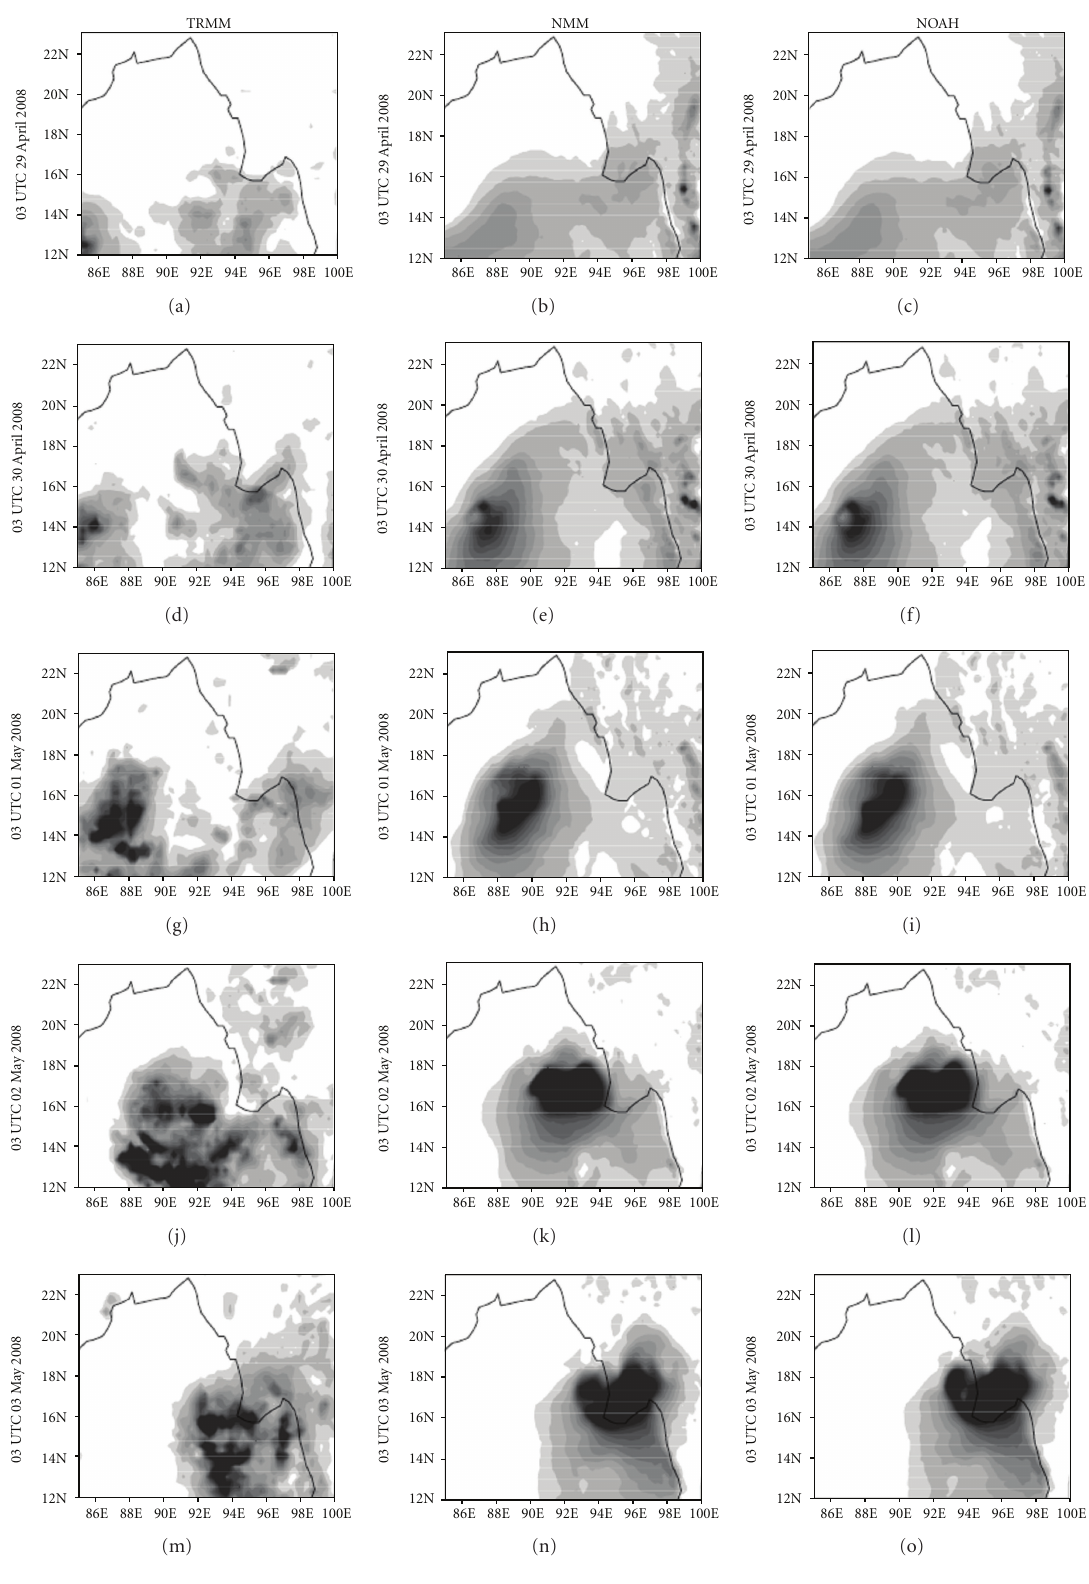
Figure 6: 24 hrs accumulated rainfall from TRMM (left panel), NMM land surface (middle panel), and NOAH land surface (right panel) valid at corresponding